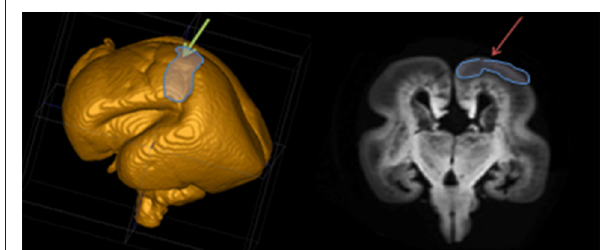
FIGURE 1 | Position of the prospective somatosensory cortex based on 3D MRI reconstruction of the post mortem